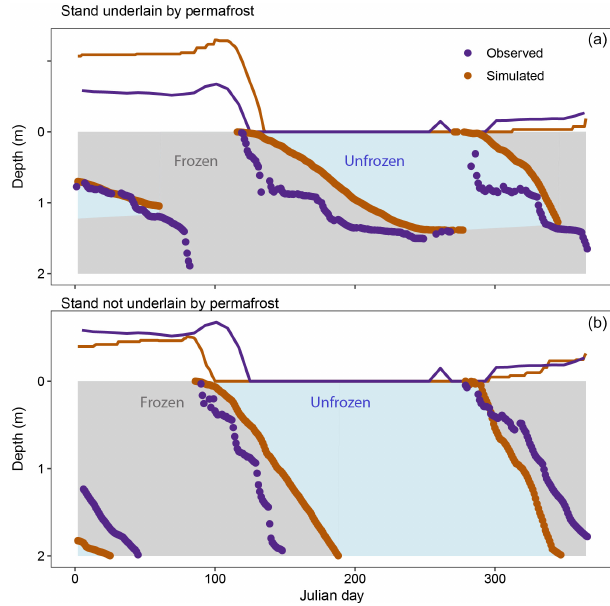
Figure 3. (a) Example of daily active layer freezing and thawing. Data from 2016 at one of seven forest stands underlain by per- mafrost. (b) Example of daily thawing and freezing. Data from 2016 at 1 of 10 forest stands not underlain by permafrost. Solid lines rep- resent snow depth. Dots represent active layer depth or depth of freezing. Gray fill represents simulated frozen soils. Blue fill repre- sents simulated unfrozen